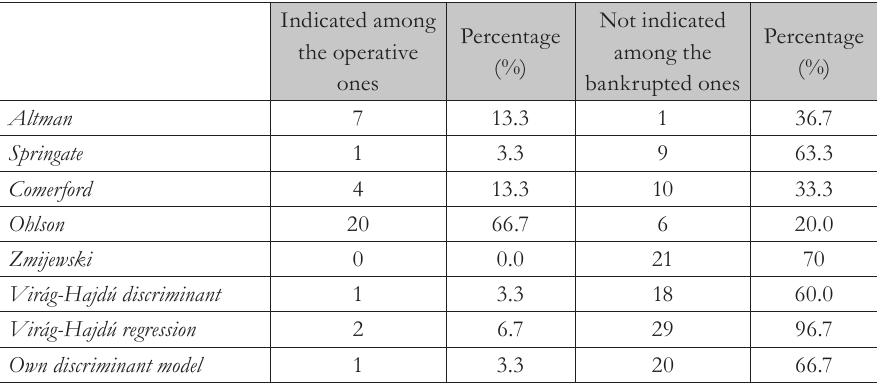
Tab. 6 – The failure values of the crisis management models regarding the validity sample (previ- ous year’s data). Source: own